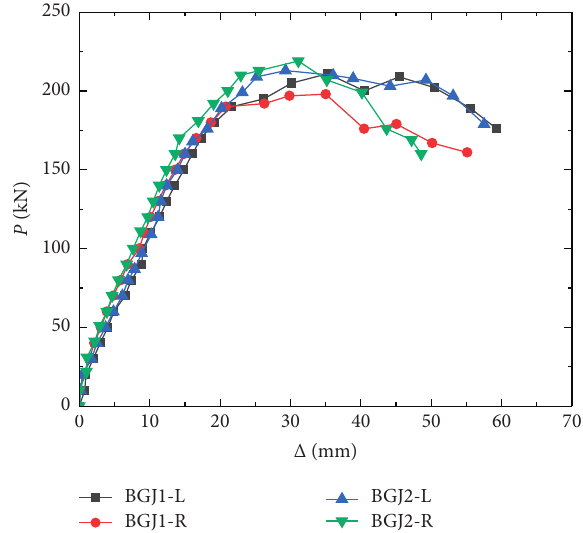
Figure 10: Load-deflection curves.